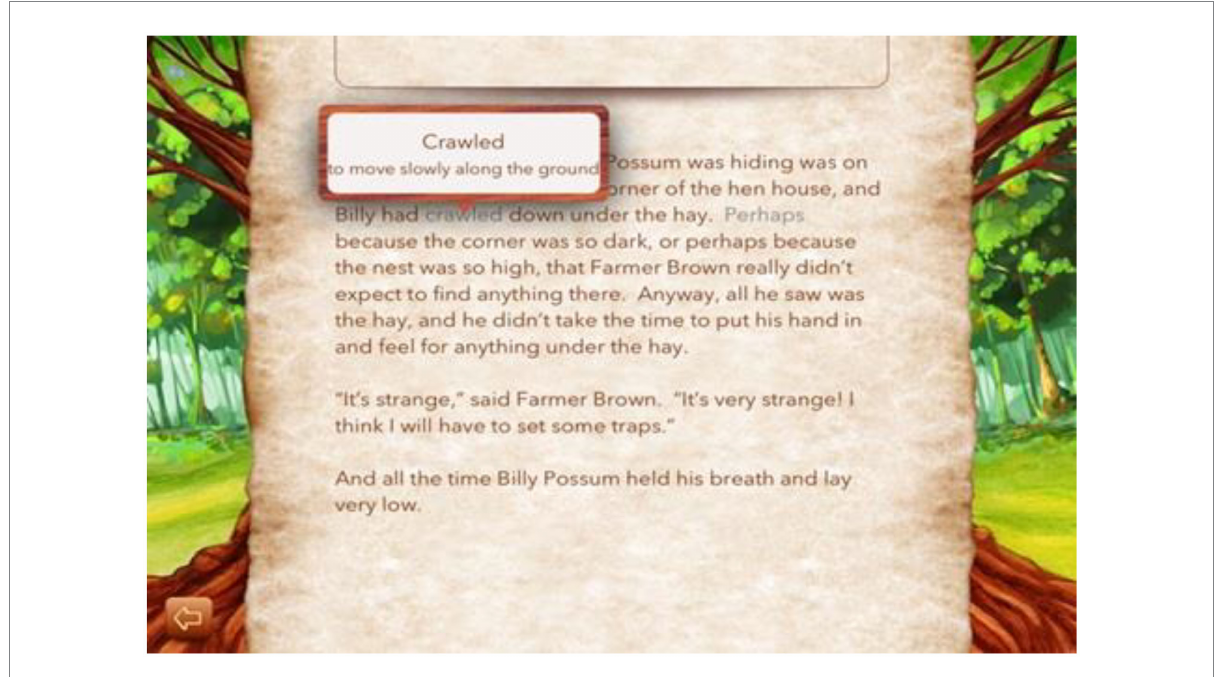
FIGURE 7 Screen shot in app of text with dictionary function